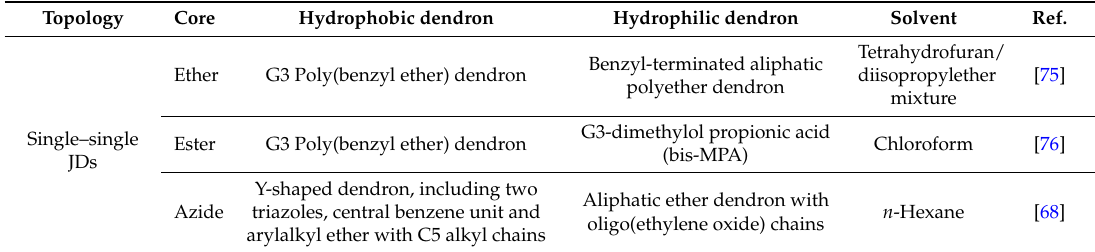
Table 1. Structural features of JDs self-assembling in organic solvents.